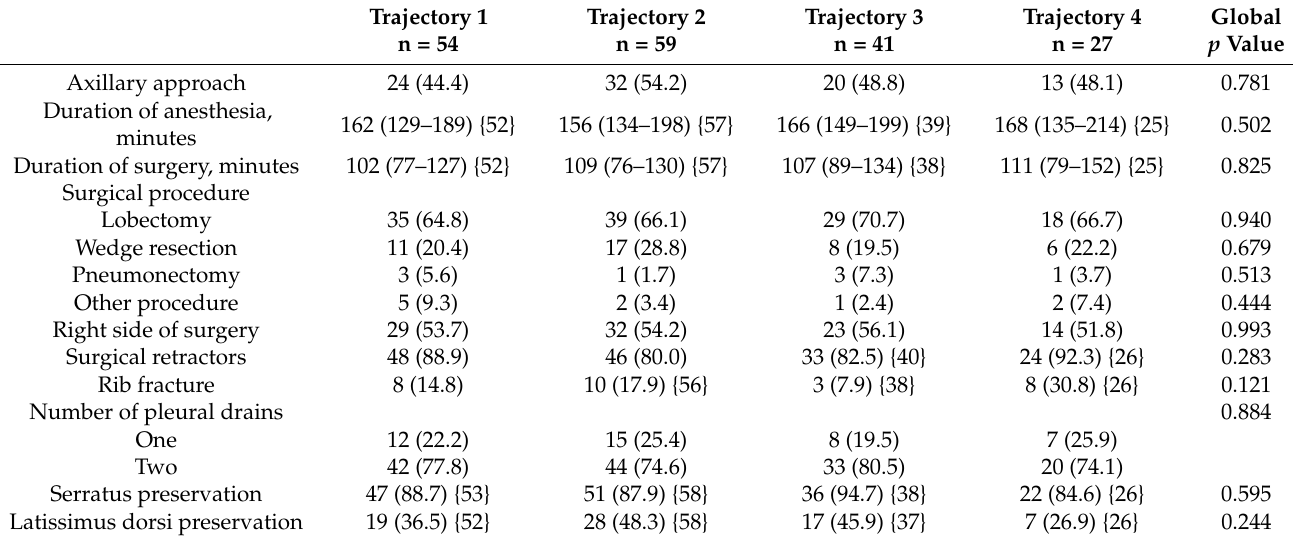
Table 5. Intraoperative variables for each trajectory